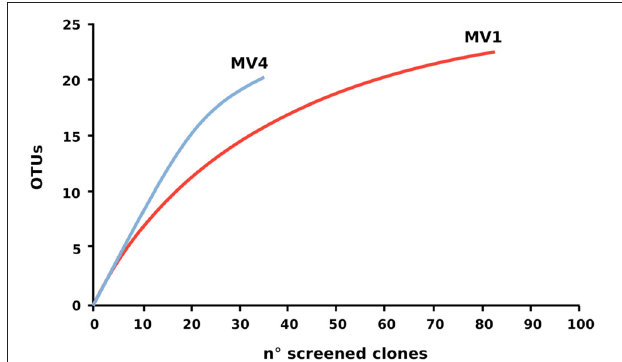
FIGURE 6 | Rarefaction curve of the 16S rRNA gene libraries. Rarefaction curves were computed using Rarefaction software